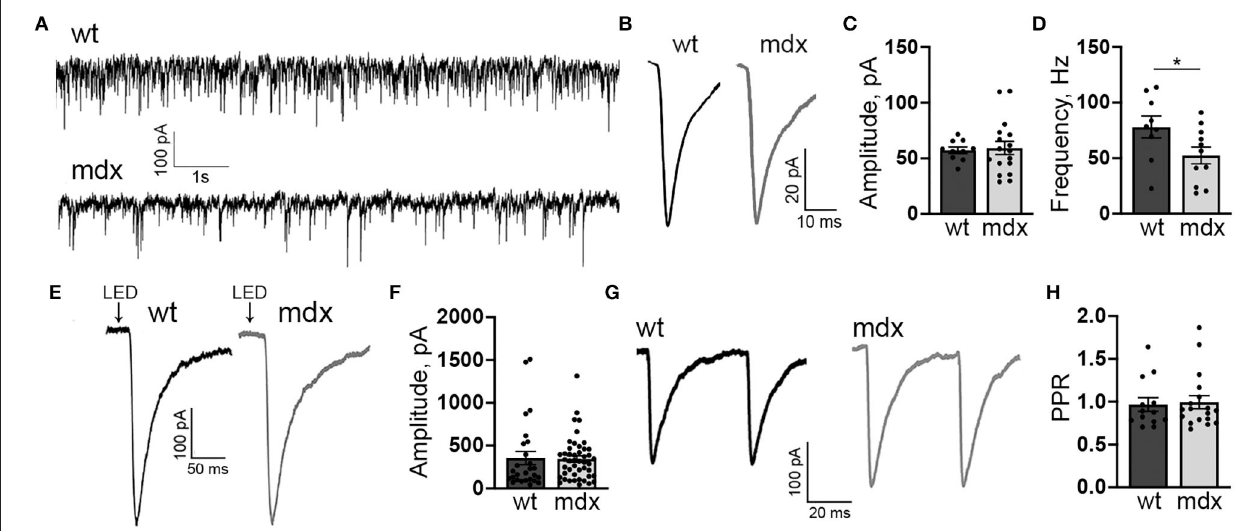
FIGURE 1 | mdx CbN neurons show reduced mIPSC frequency. (A) Representative trace of mIPSC recording in YFP + CbN neurons from wild type (top trace) and mdx (bottom trace) mice. Scale bar: 100pA, 1s. (B) Representative average mIPSC traces from a wild-type (left, black trace) and mdx (right, gray trace) CbN neuron. Traces are averages of all mIPSCs over a 2min recording. Scale bar: 20pA, 10ms. (C,D) Summary graphs of mean mIPSC amplitude (C) and frequency (D) from wild-type (dark gray bars, n = 9 cells from 3 animals) and mdx (light gray bars, n = 11 cells from 4 animals) CbN neurons. (E) Representative current traces following photolytic uncaging of RuBi-GABA recorded from YFP + CbN neurons of wild-type (left, black trace) and mdx (right, gray trace) mice. Traces are averages of 6–10 sweeps. Scale bar: 100pA, 50ms. (F) Summary graph of mean GABA A receptor current amplitude from wild-type (dark gray bars, n = 27 cells, 4 animals) and mdx (light gray bars, n = 46 cells, 5 animals) CbN neurons. (G,H) Representative traces of pairs of IPSCs (50ms inter-stimulus interval) evoked in YFP + CbN neurons (G) and a summary graph of the paired-pulse ratio (H) from wild-type (dark gray bar, n = 13 cells, 3 animals) and mdx (light gray bar, n = 18 cells, 4 animals) cells. Scale bar: 100pA, 20ms. Traces are averages of 6–10 trials. Error bars indicate SEM. * p ≤ 0.05.